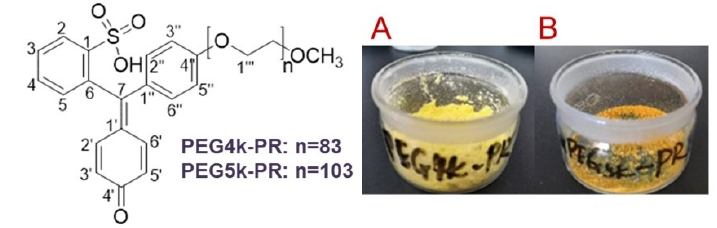
Figure 2. Structure and appearance of PEG4k-PR ( A ) and PEG5k-PR ( B ). Table 2. 1 H-NMR analyses of PEG4k/5k-PR.